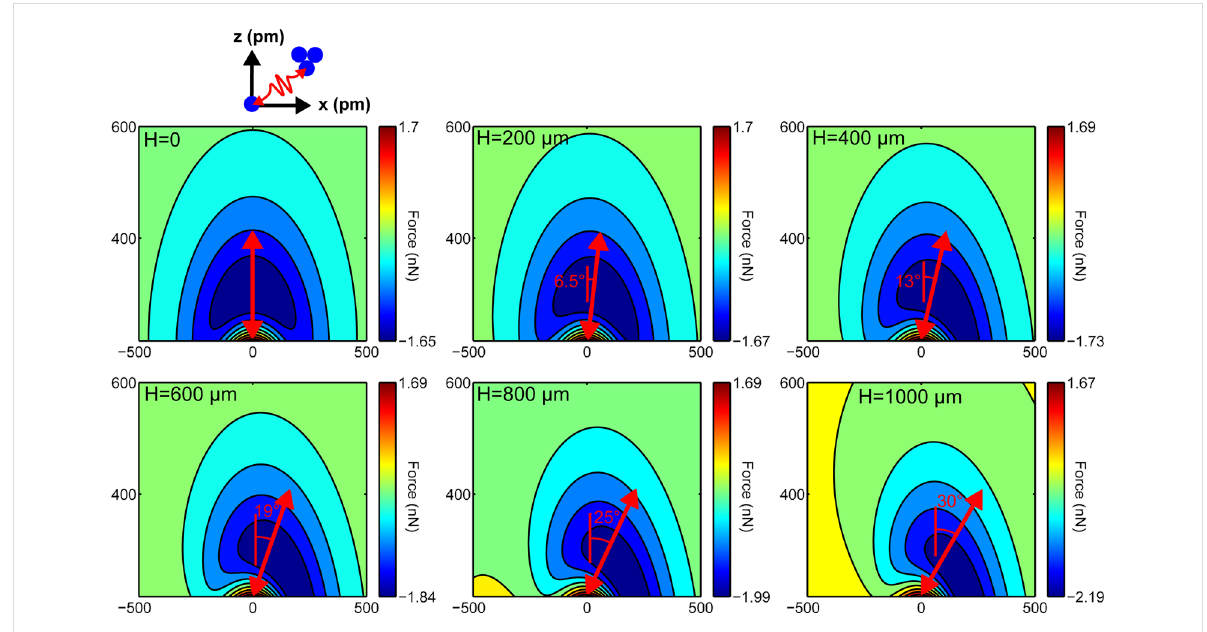
Figure 5: Reconstructed grid spectroscopy images for Si–Si Morse potential with varying tip heights. Red arrows are drawn to scale to indicate the direction of the tip motion. The extrema of the scale bar show the error in the reconstructed force.